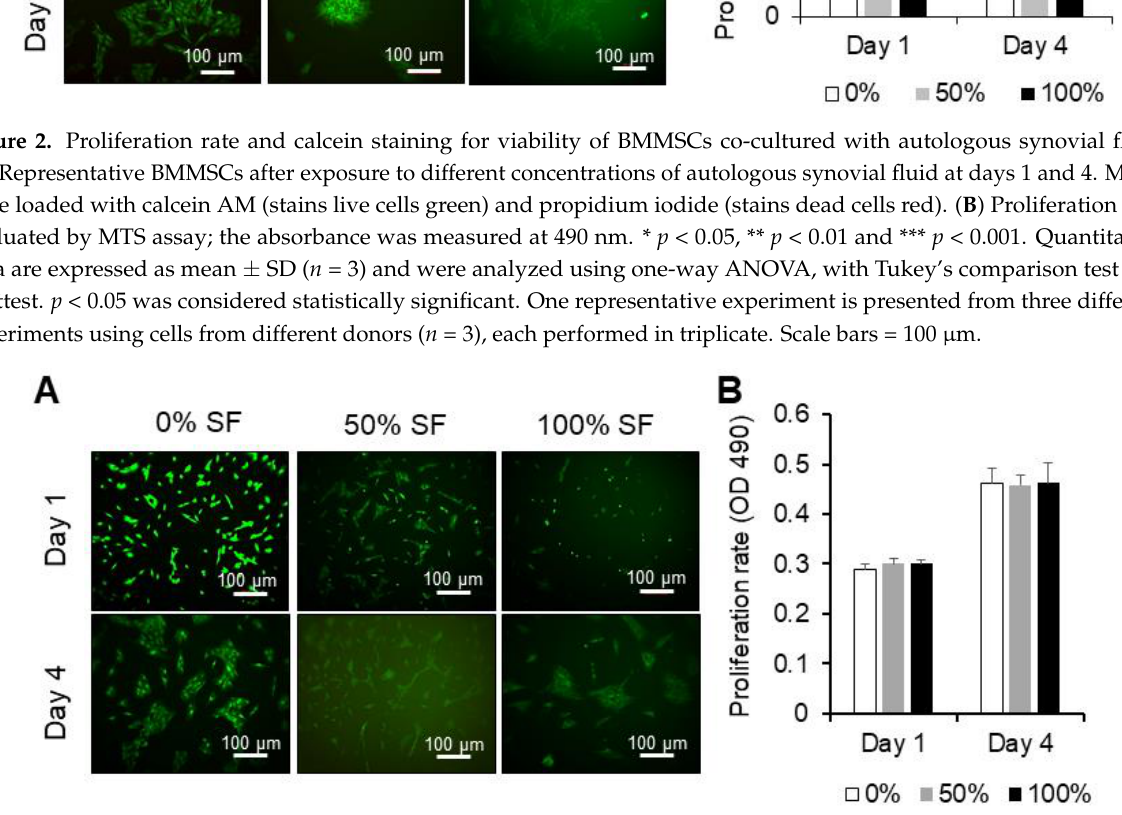
Figure 2. Proliferation rate and calcein staining for viability of BMMSCs co-cultured with autologous synovial fluid. ( A ) Representative BMMSCs after exposure to different concentrations of autologous synovial fluid at days 1 and 4. MSCs were loaded with calcein AM (stains live cells green) and propidium iodide (stains dead cells red). ( B ) Proliferation was evaluated by MTS assay; the absorbance was measured at 490 nm. * p < 0.05, ** p < 0.01 and *** p < 0.001. Quantitative data are expressed as mean ± SD ( n = 3) and were analyzed using one-way ANOVA, with Tukey’s comparison test as a posttest. p < 0.05 was considered statistically significant. One representative experiment is presented from three different experi- ments using cells from different donors ( n = 3), each performed in triplicate. Scale bars = 100 µm.